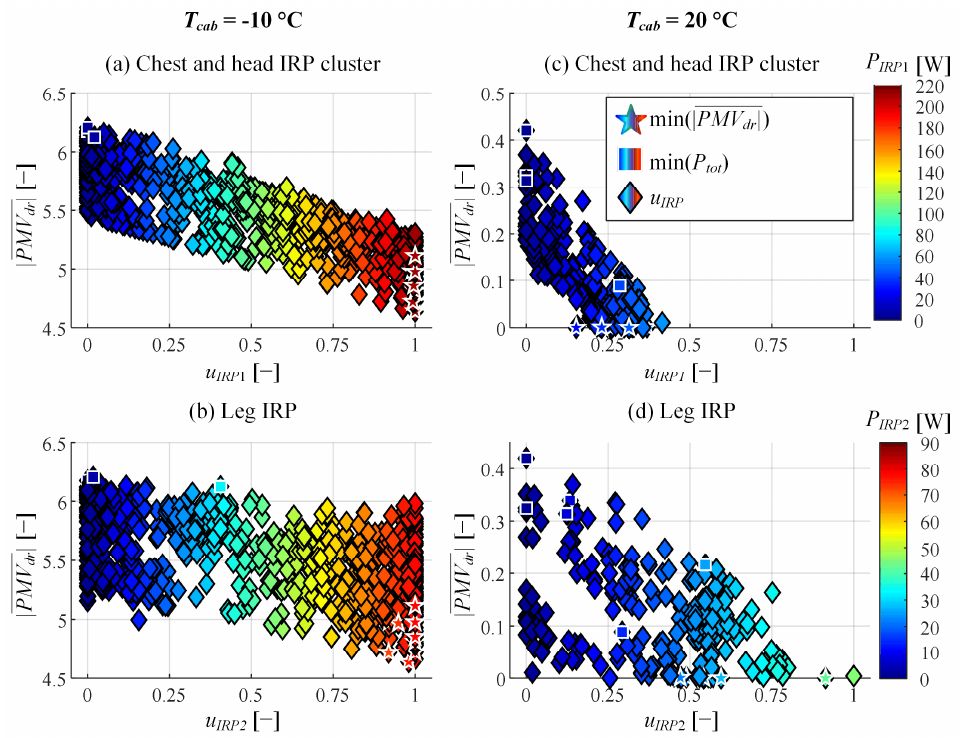
Figure 8. Optimised IRP control inputs corresponding to Pareto frontiers from Figure 5a ( a , b , T cab = − 10 °C) and Figure 5e ( c , d , T cab = 20 °C).